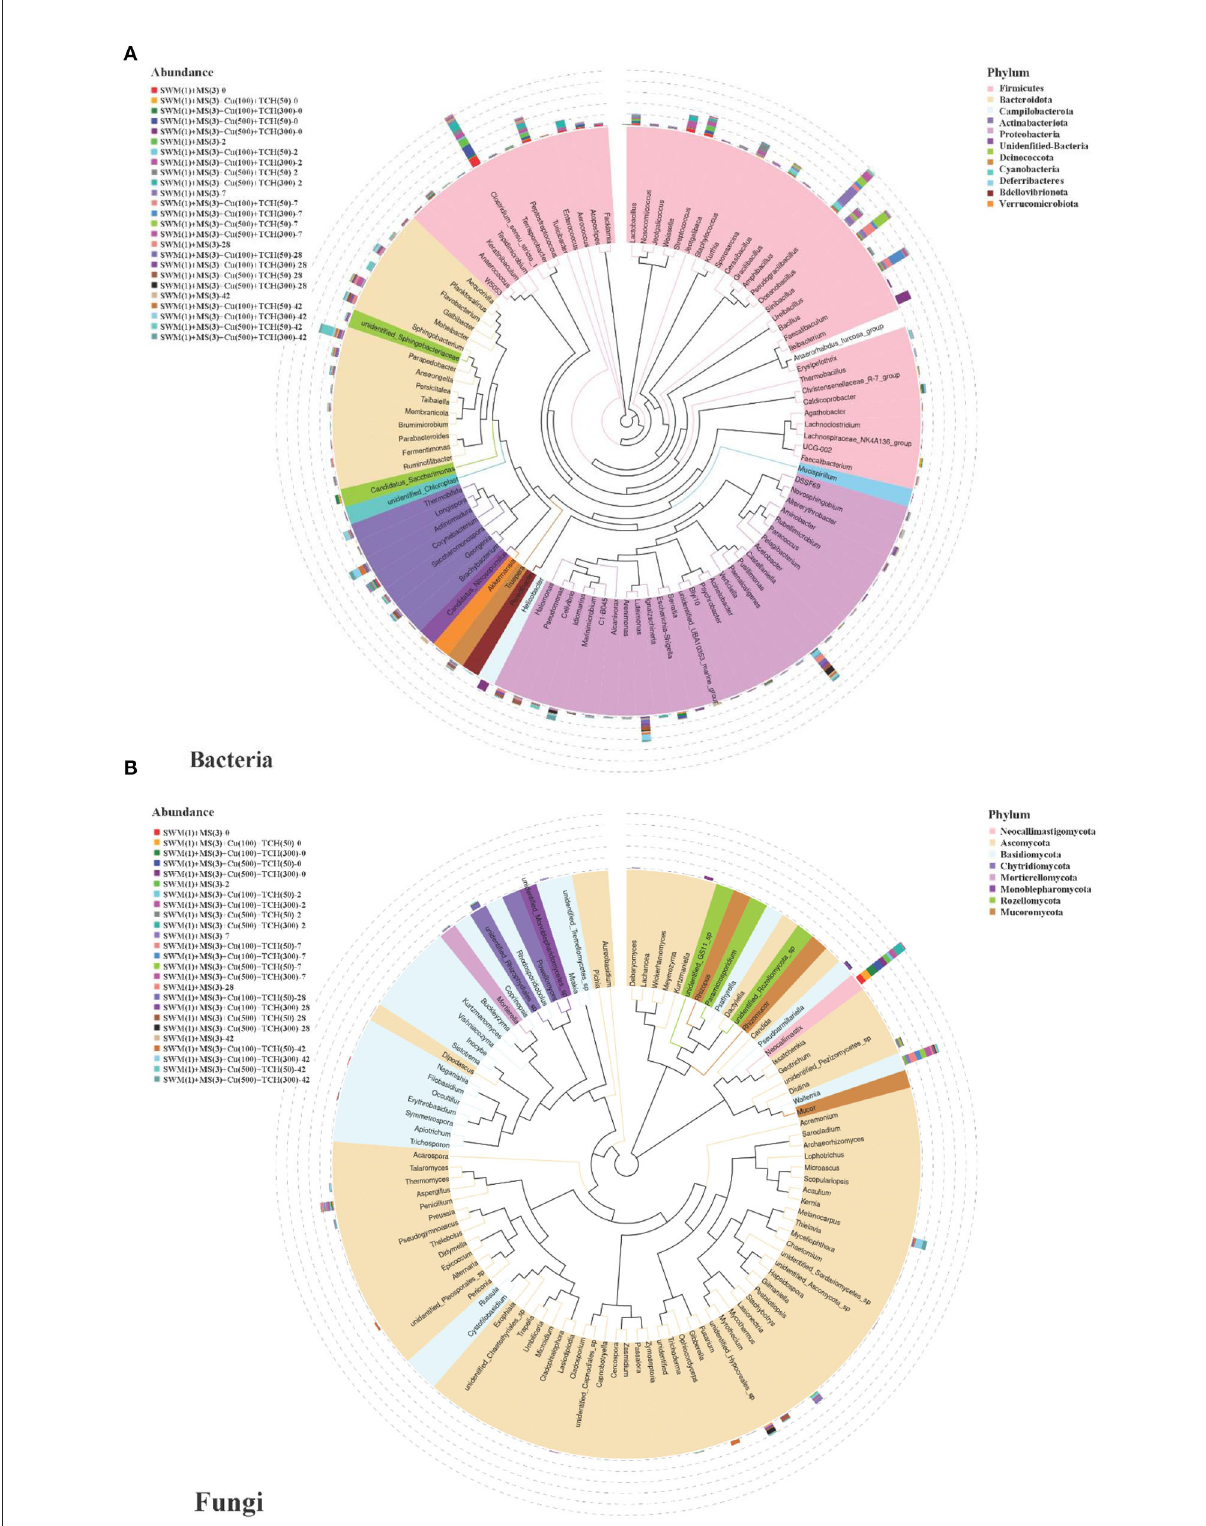
FIGURE6 Constructed phylogenetic trees related to bacterial (A) and fungal (B) communities at the genus